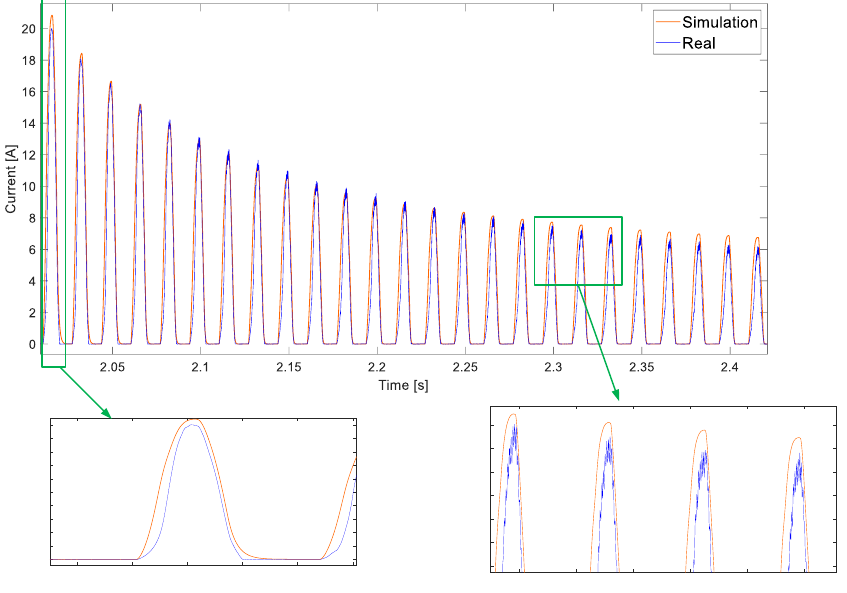
Figure 19. Comparison of the measured and simulated waveforms of a drill. Adapted from